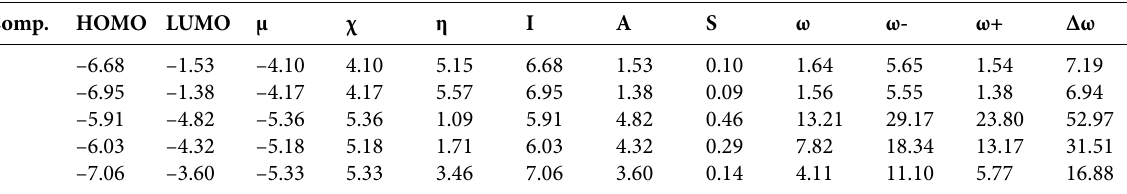
Table 3. The calculated quantum chemical descriptors (eV).